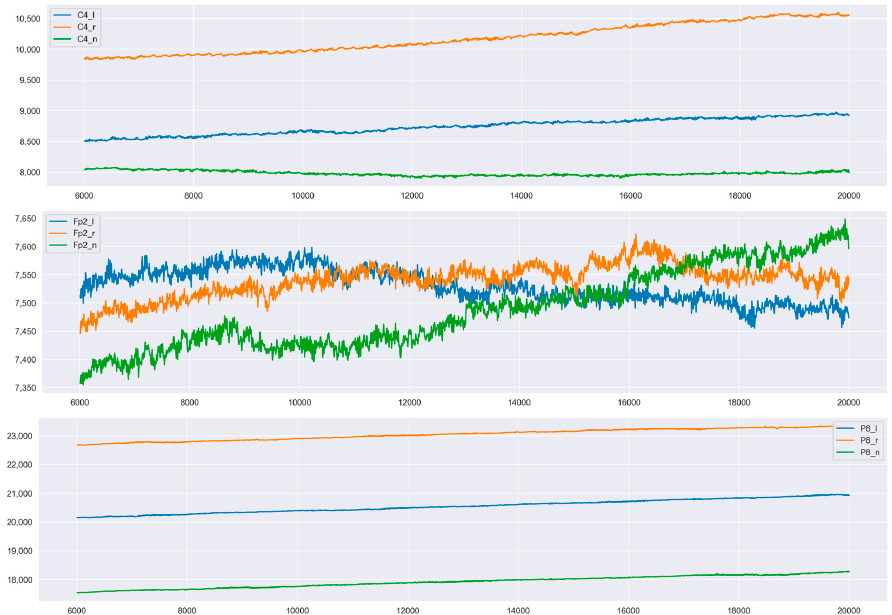
Figure 5. Changes in signals for one of the subjects for three states (rest, movement to the left, movement to the right) over time. Orange represents left hand, blue represents right hand, and green represents neutral state of mind.